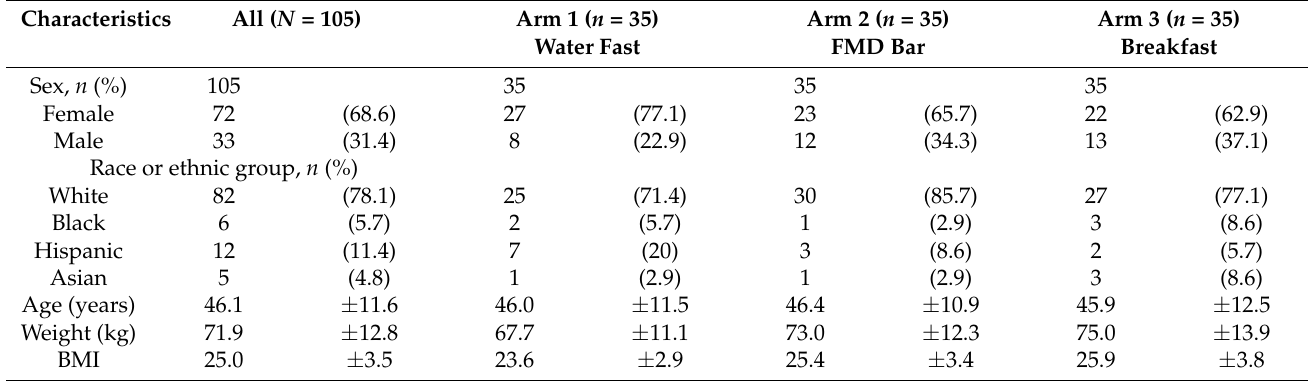
Table 2. Baseline sample characteristics. Continuous variables are described using mean ± standard deviation, while categorical variables are described with count